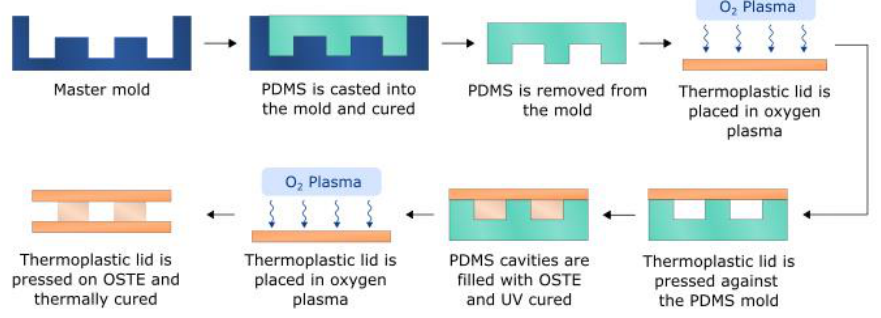
Figure 2. OSTE-COC single-channel EV separation device fabrication workflow.